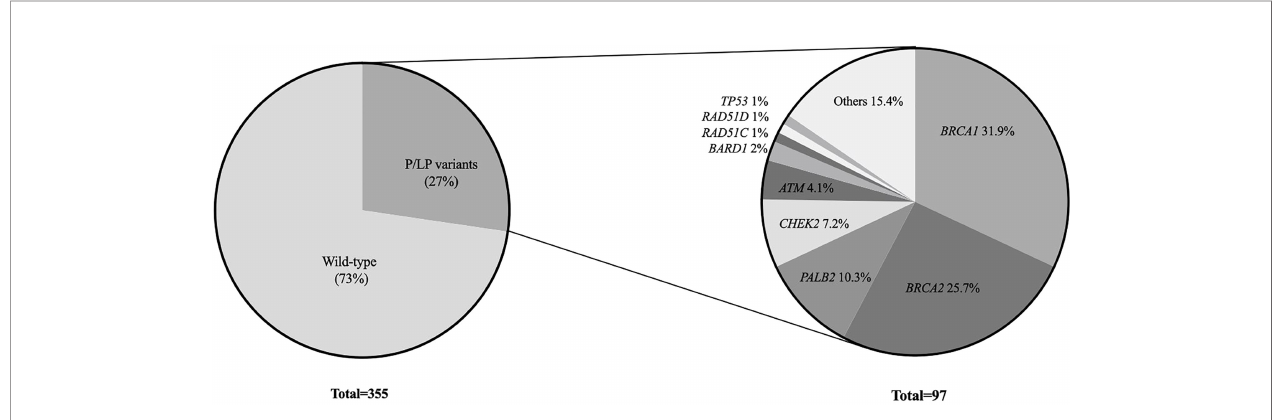
FIGURE 1 | Oncoplot with P/LP variants: variants types and frequencies according to age at fi rst diagnosis and primary tumor site.